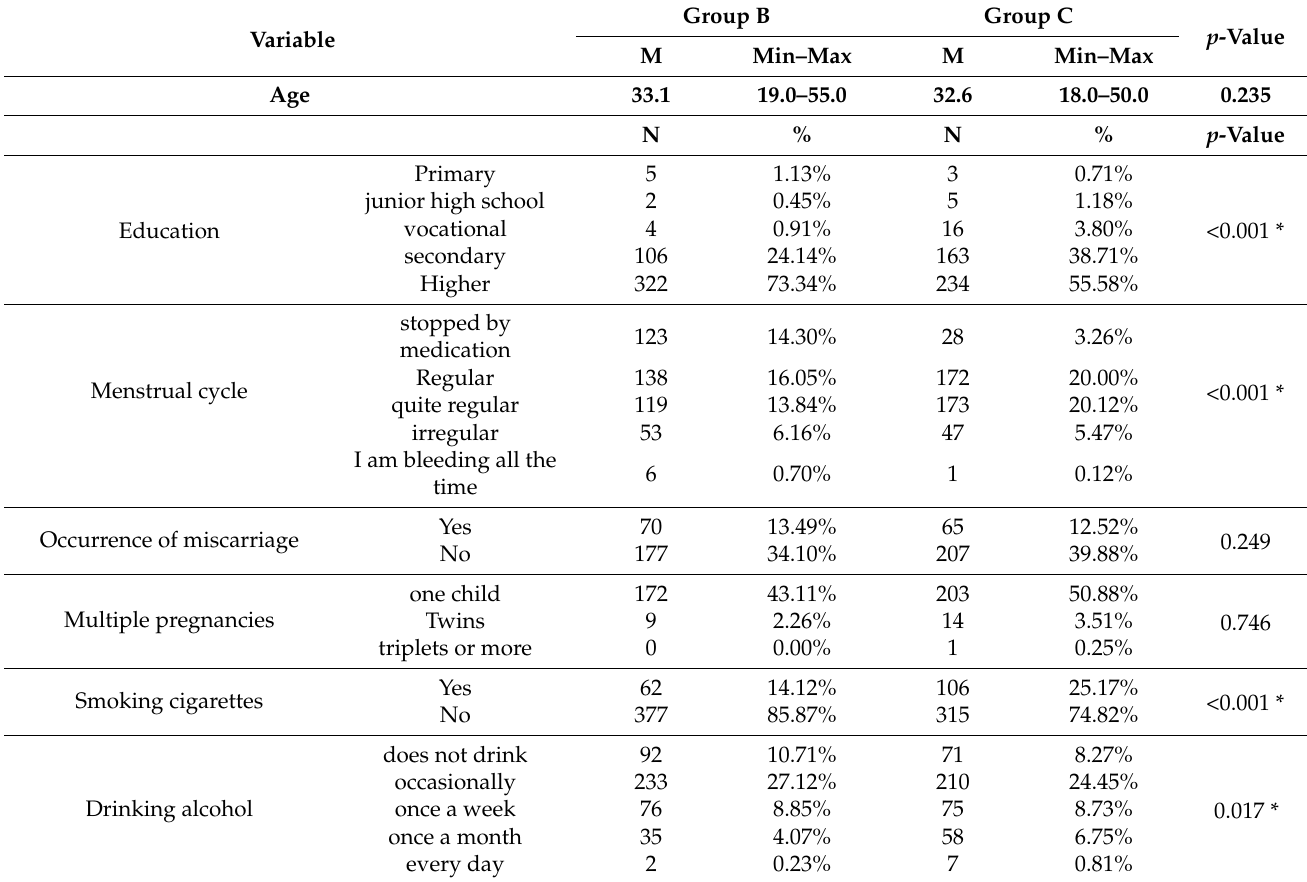
Table 1. Comparison of the demographic data of the test group and the control group.